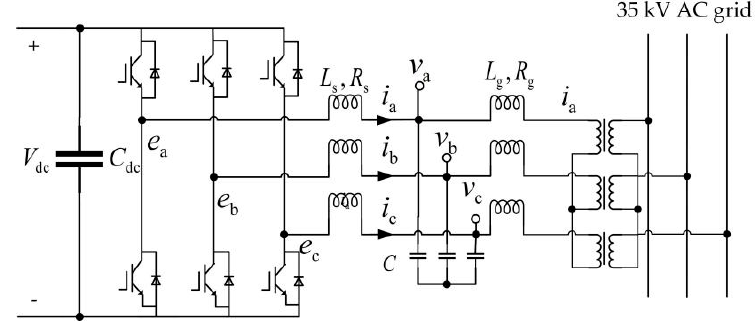
Figure 3. The main circuit of the synchronverter-based RBE feedback system.